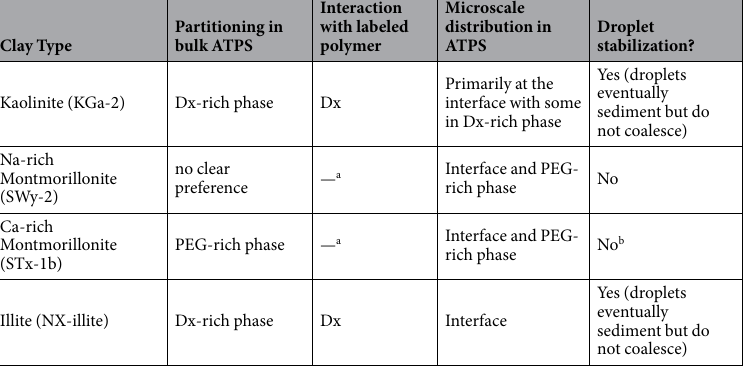
relaxation leading to non-uniform shapes. The non-spherical droplets indicate the presence of arrested coales- cence of kaolinite-coated droplets 60, 61 . Over time, illite or kaolinite clay-clad particles sedimented to the bottom of the sample chamber but they did not coalesce even when droplets were in contact. In contrast, droplets in montmorillonite-containing samples coalesced readily upon contact, with stabilization only occurring when accumulations of clay particles in the PEG-rich phase physically prevented Dx-rich droplets from contacting each other (Supplementary Fig. S10). The fact that interfacial coatings of illite or kaolinite can stabilize Dx-rich droplets against coalescence in a continu- ous PEG-rich phase is perhaps counterintuitive since these clays appear to be wet preferentially by the Dx-rich phase in bulk partitioning experiments, and also are coated with a layer of adsorbed polymer (Table 2). When spherical colloidal particles provide steric stabilization, they are generally preferentially wetted by the continuous phase (Bancroft rule) 39, 62–64 . Indeed, clay particles form oil-in-water Pickering and water-in-oil inverse Pickering emulsions depending on their surface hydrophilicity/hydrophobicity 31, 34, 36 . Our observations are more similar to those of Erne and coworkers for gibbsite nanoplates in a Dx/gelatin ATPS, which stabilized droplets of either phase in the other 40 . Three-phase contact angle estimates from measurements in which Dx-rich droplets sur- rounded by PEG-rich phase were placed on clay-coated substrates indicated contact angles greater than 90° for all four clay types (Fig. 4 and Supplementary Fig. S11). Kaolinite and illite, which interact with Dx and form clay-clad droplets, had contact angles, θ ~ 101 ± 7° and 107 ± 5°, respectively, while estimated contact angles for Na-rich and Ca-rich montmorillonite, which do not show effective droplet stabilization, were 128 ± 9° and 135 ± 10°,